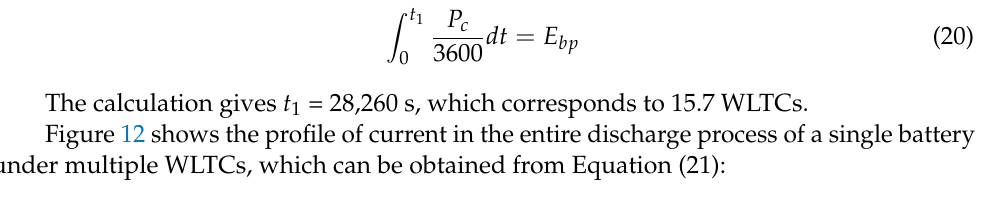
where P c is the output power of the battery pack and P t , m is the traction power of the vehicle under multiple WLTCs, i.e., multiple cycles of P t ,1 .